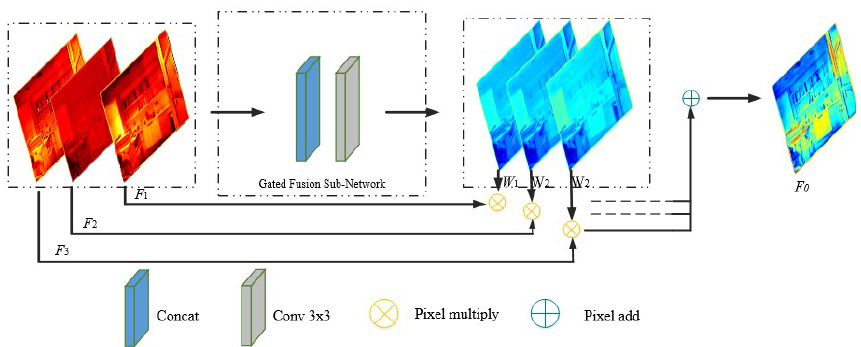
Figure 3. Gated fusion